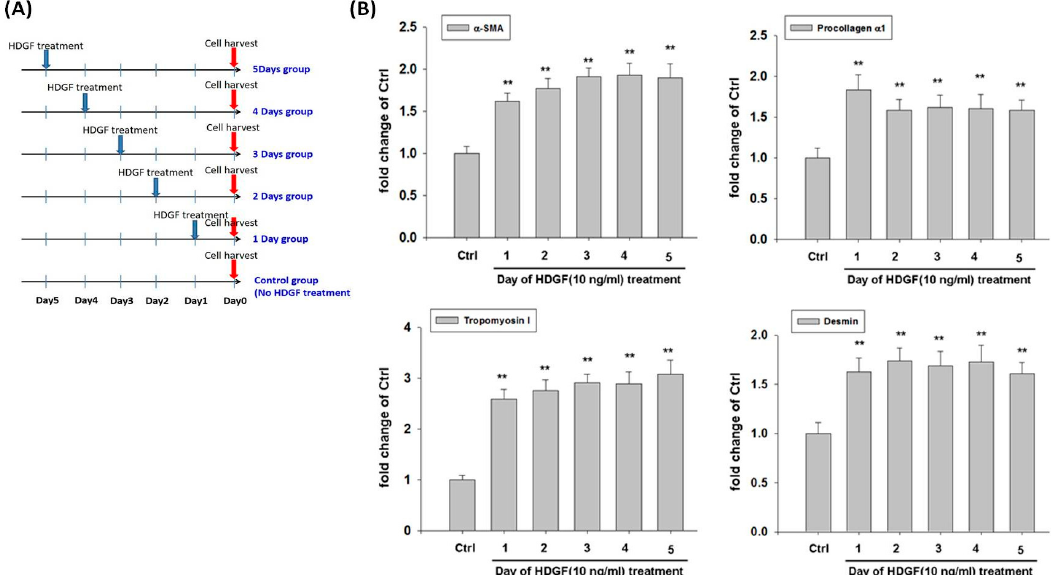
culture. HBMMSC were treated with HDGF at various time points in the absence of serum. HBMMSC then were harvested at the same day. ( B ) HDGF stimulates expression of myofibroblast markers in HBMMSCs. HBMMSCs were treated with HDGF 10 ng/ml) for various periods (1, 2, 3, 4 or 5 days), respectively. The effect of HDGF on expression of myofibroblast markers was measured by RT q-PCR. ** p ＜ 0.01 versus control (mean ± SD, n = 3).